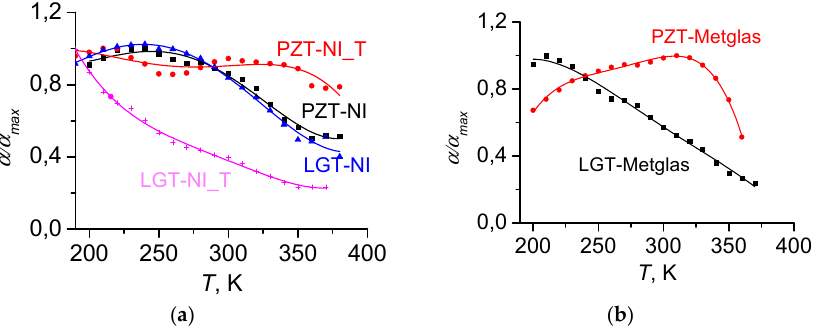
Figure 13. Dependences of the normalized ME coefficient α ´ on the temperature for structures of different compositions comprising Ni ( a ) or Metglas layers ( b ). The index “_T” designates structures with the thickness of the Ni layer of 200 μ m.